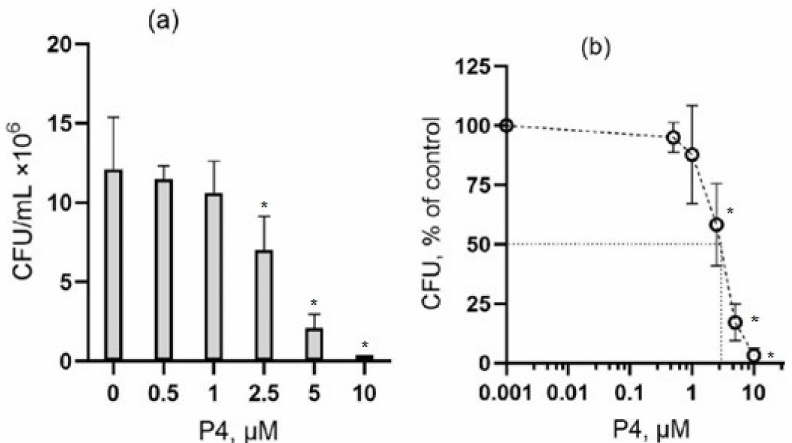
Figure 1. The dose-dependent effect of peptide P4 on the viability of Gram-negative bacteria E. coli. ( a ) The number of colonies (CFU, colony-forming units, number of cells/mL) that were found after incubation of exponentially growing bacterial cells in the presence of peptide P4 at a concentration range from 0 to 10 µ M. All samples contained 1% DMSO and 1 mg/mL albumin (see section “Materials and Methods”). ( b ) The dose–response curve shows the effect of peptide P4 in the experiment illustrated in panel ( a ), the number of colonies that were found in the absence of the peptide was taken as 100%. * The difference from the control value is statistically significant at p ≤